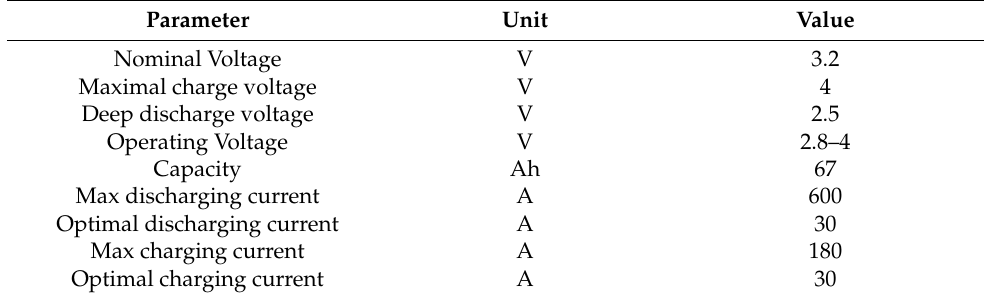
Table 1. Lithium cell parameters Winston FLP060AHA.